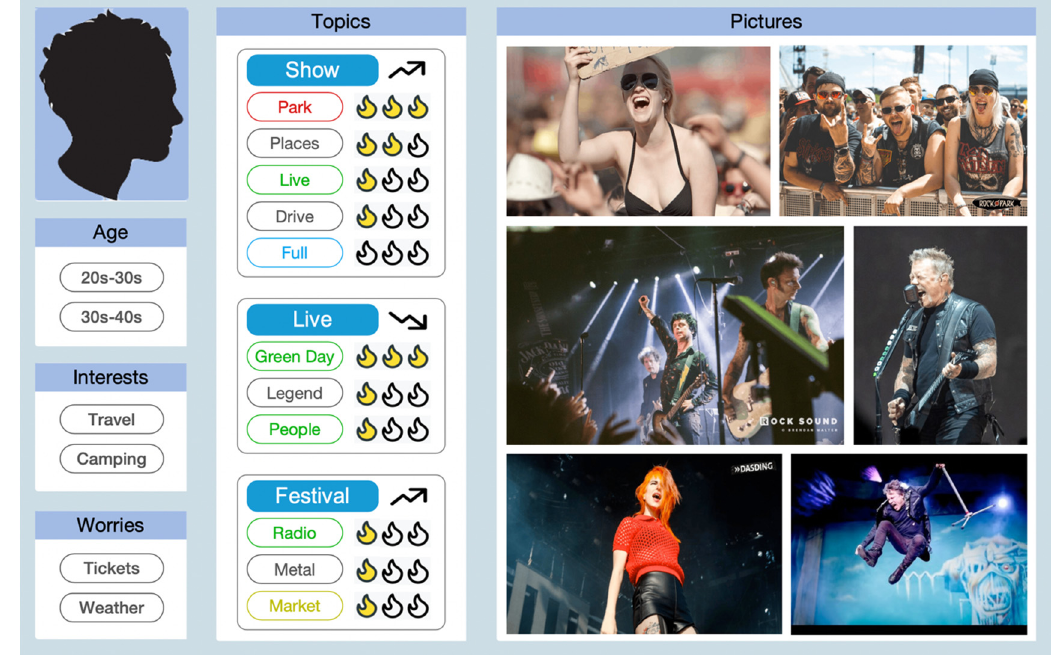
Figure 4. User ‐ constructed topic modelling ‐ assisted thin persona. Figure 4. User-constructed topic modelling-assisted thin